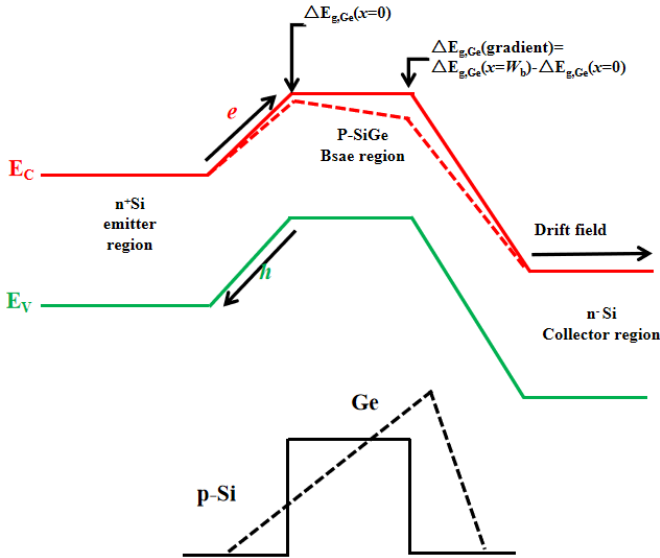
Figure 2. Schematic diagram of the band structure of the SiGe